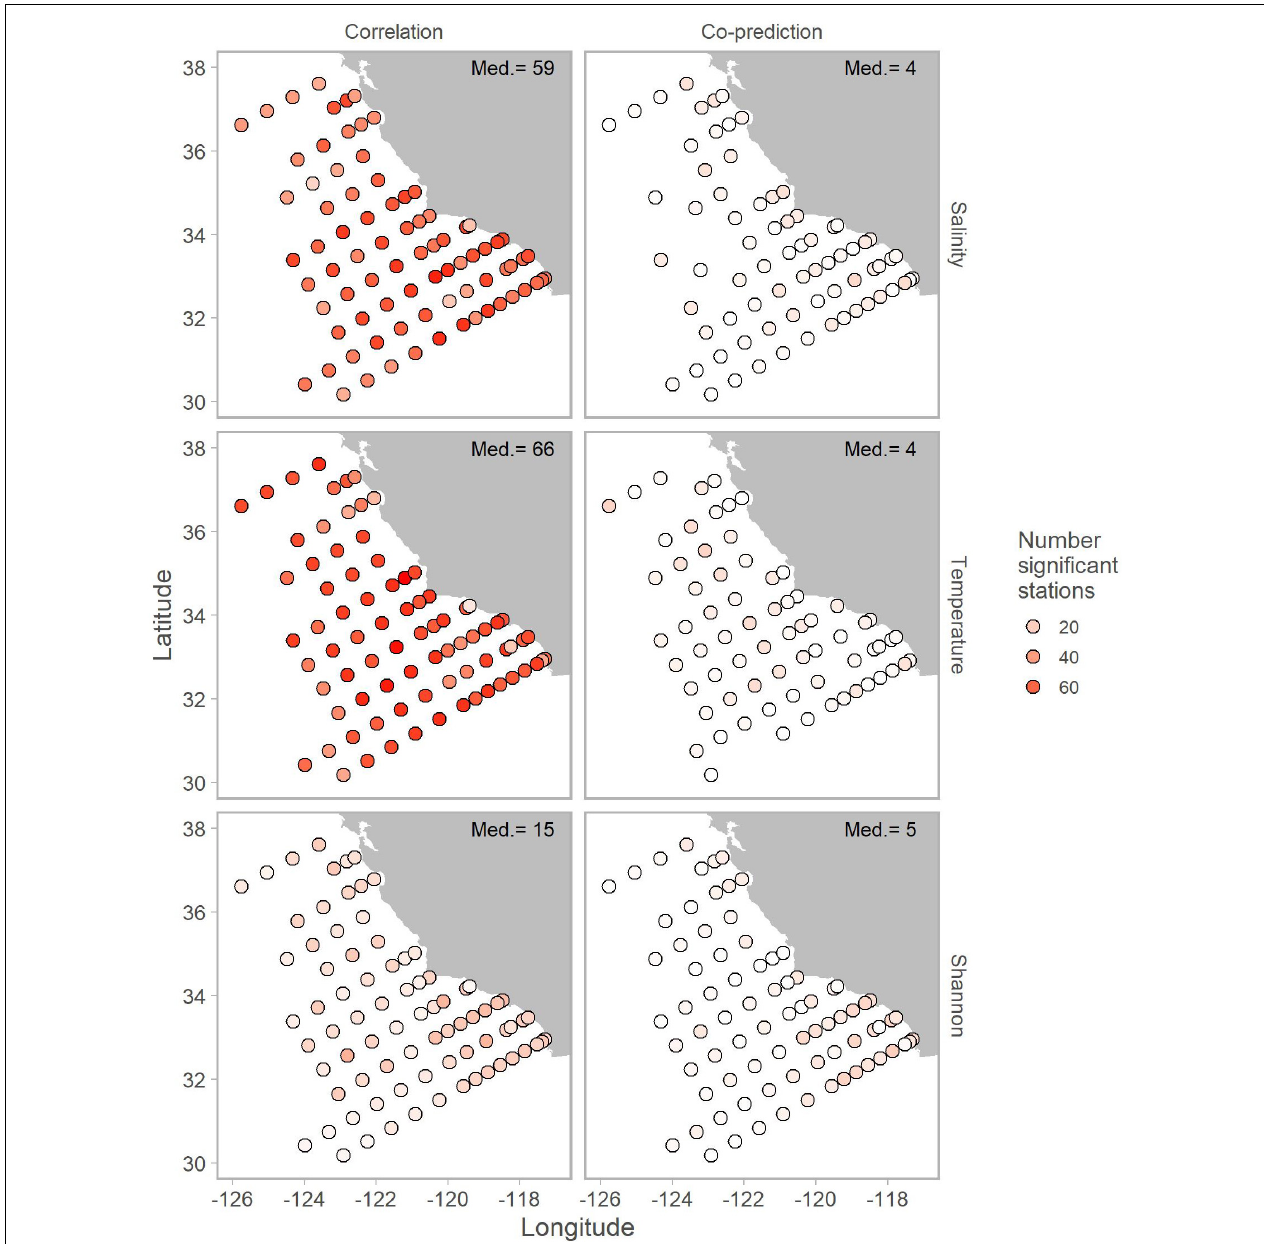
FIGURE 3 | Map of correlated (left column) and co-predicted (right column) stations shown with shades of red. The number of correlated stations was highest for salinity (first row) and temperature (second row). Median number of significant stations are shown in the top right of each panel.